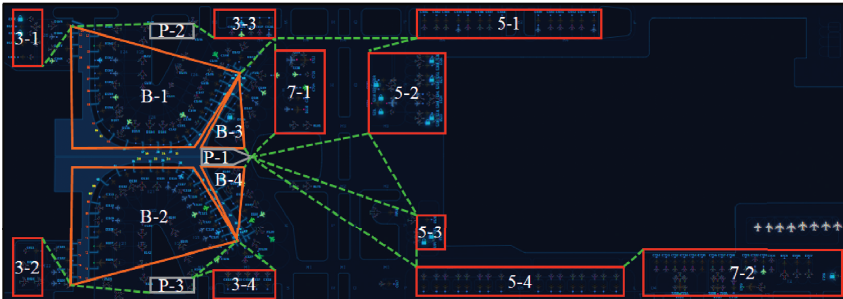
Figure 3: Road network connection between the regions.